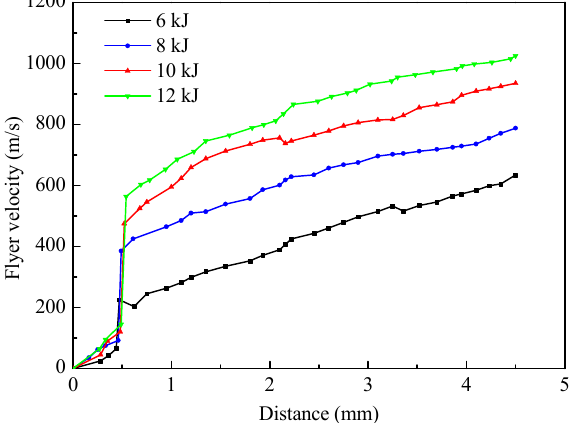
Figure 4. Flyer sheet velocity traces at 6 kJ, 8 kJ, 10 kJ, and 12 kJ input energies.